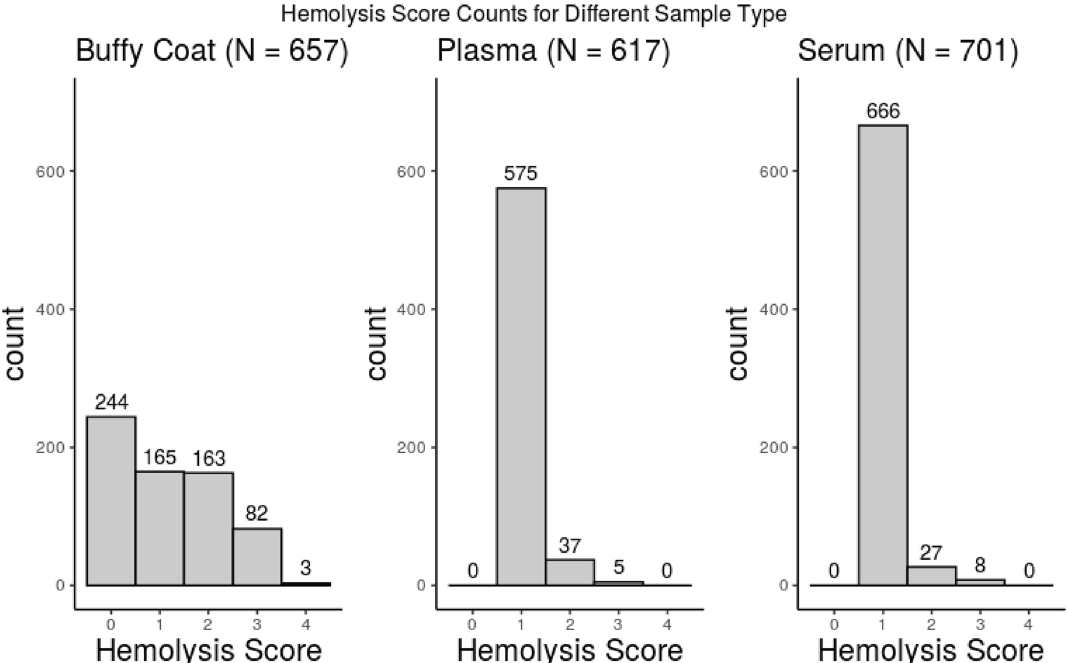
Figure 2. Hemolysis score distribution of sample count buffy coat (N = 657), Plasma (N = 617), and Serum (N = 701) samples included in this